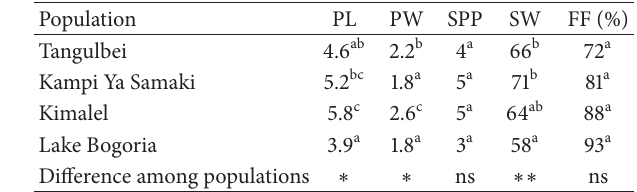
Table 6: Pod and seed characteristics of S. senegal within Lake Baringo woodland ecosystem. Population PL PW SPP SW